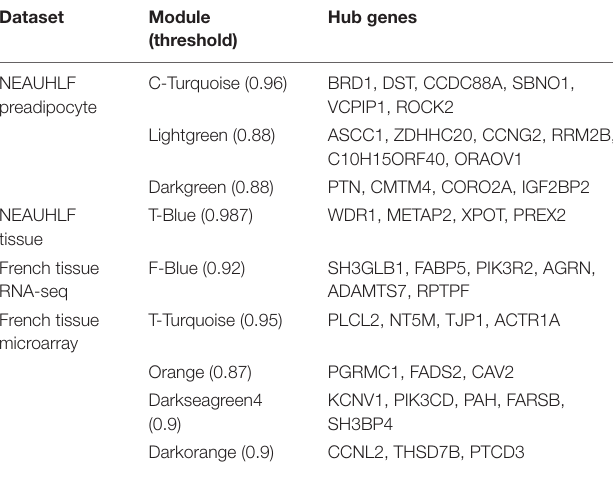
TABLE 1 | Hub genes in modules identified to be related to chicken fat